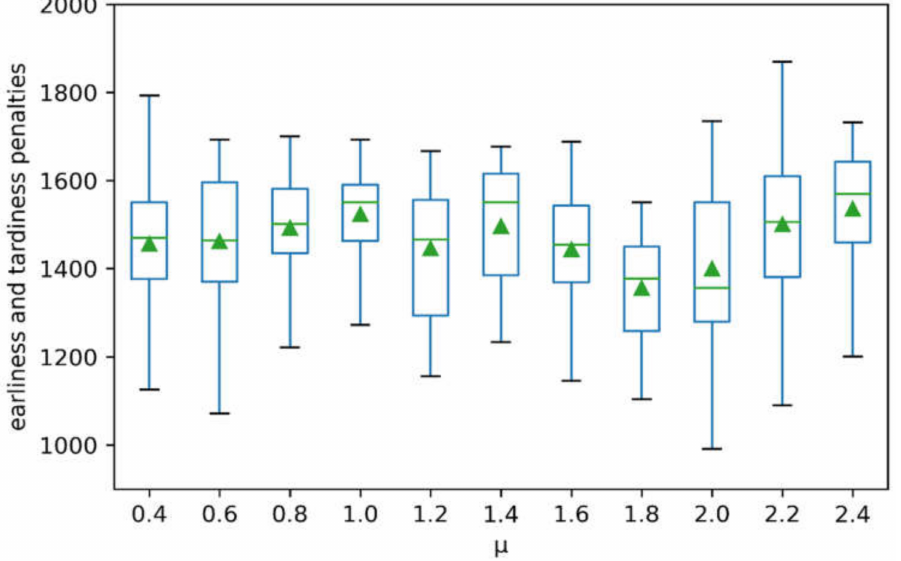
Figure 3. Box plots of earliness and tardiness penalties at different values of µ